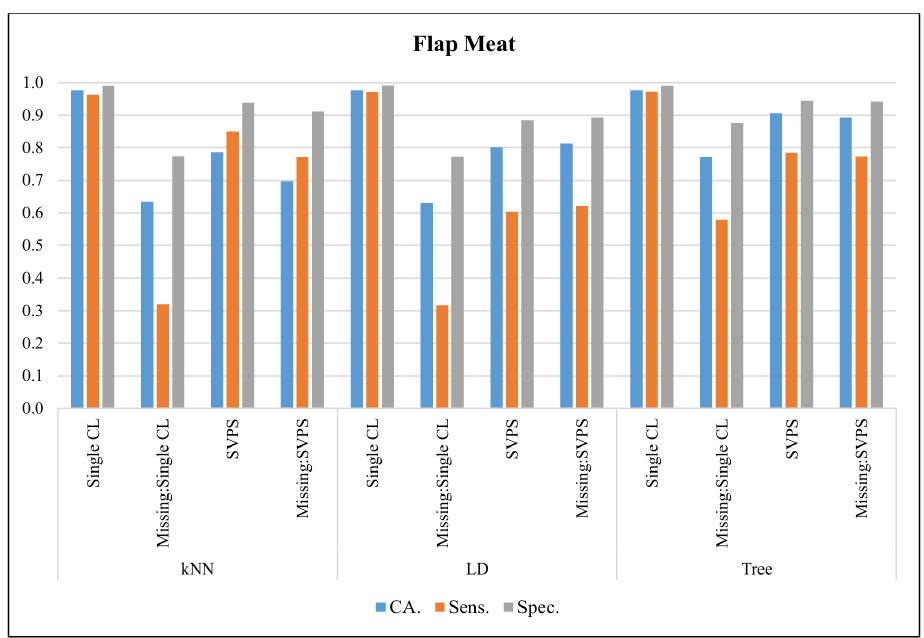
Figure 11. Classification results for Flap Meat